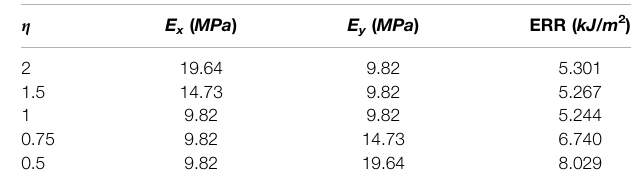
TABLE 4 | ERR against the material orthotropy ratio η